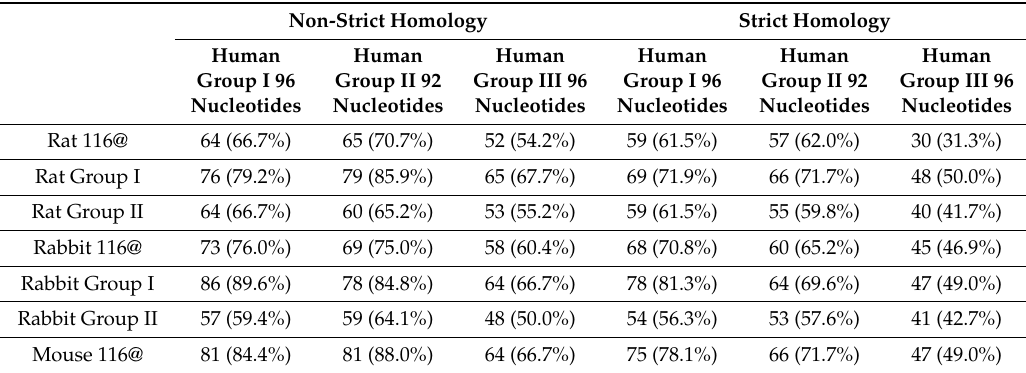
Figure 1. Comparison of genomic sequences of the SNORD116 locus from model organisms used for most biological research. Sequences from human ( Homo sapiens ), chimpanzee ( Pan troglodytes ), rhesus ( Macaca mulatta ), rabbit ( Oryctolagus cuniculus ), rat ( Rattus norvegicus ) and mouse ( Mus musculus ) were analyzed and the composite sequence shown. Nucleotides AGCT shown are present in 90% or greater of the transcripts at that position, while IUPAC codes are used for positions with one or more variable nucleotides. ( A ) Alignment of SNORD116@ consensus sequences displaying sites of non-strict homology. A dot (.) indicates non-strict homology with the human sequence for the given nucleotide position. ( B ) Alignment showing all nucleotides of consensus sequences used in ( A ). Sequences used for the analysis were obtained from Ensembl builds. The build and the number of SNORD116 sequences analyzed are shown after the common name of the organism: human (n = 30, GRCh38.p10), chimp (n = 28, CHIMP2.1.4), rhesus (n = 29, Mmul_8.0.1), rabbit (n = 29, OryCun_2.0), rat (n = 26, Rnor_6.0) and mouse (n = 17, GRCm38.p5). The C and C’ boxes are highlighted in yellow, while the D and D’ boxes are highlighted in blue. Nucleotides that do not meet the 90% frequency threshold are indicated using IUPAC ambiguity codes. Grey-shading indicates regions of insertion/deletion in some sites of the group. Frequency for qualifying as in/del site is 10% or greater. A dot (.) indicates non-strict homology with the human sequence for the given nucleotide position. A tilde (~) indicates a gap in consensus sequence compared to the aligned consensus sequence. An asterisk (*) indicates perfect homology with the human sequence for all nucleotides in the site above. Table 3. Homology comparison of consensus sequences for SNORD116 groupings between human and rat, rabbit and mouse. The number of homologous nucleotide sites is